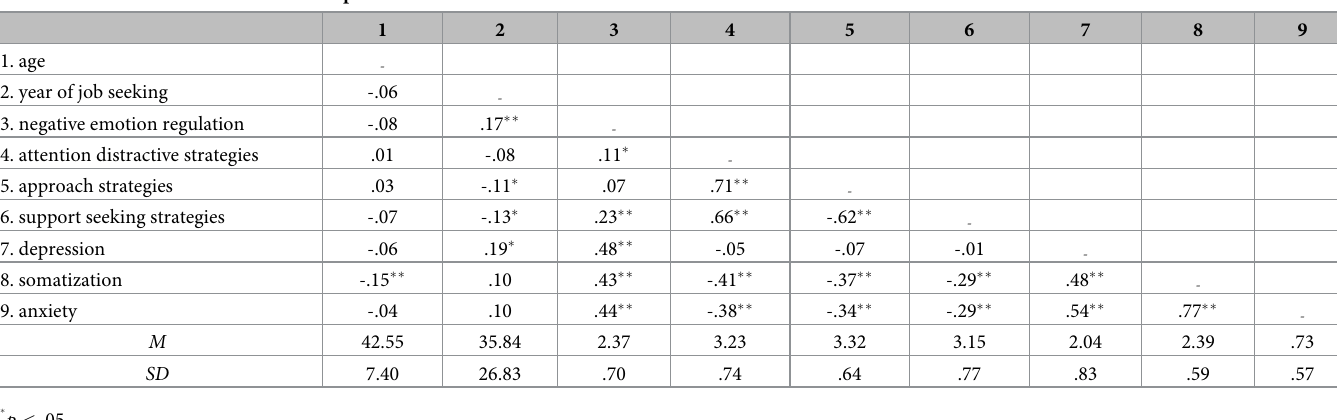
Table 1. Bivariate correlations and descriptive statistics.